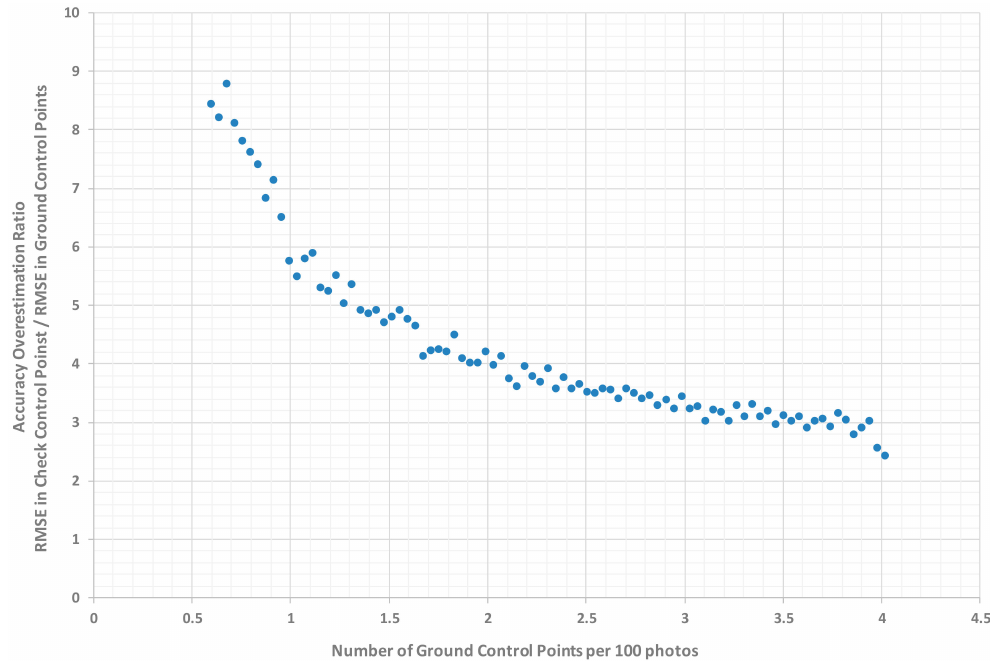
Figure 7. Overestimation of the accuracy when measured using only GCPs rather than independent check points. Note that a minimum of 15 GCPs in the 2415-image dataset has been considered to obtain overestimation ratios under 10.